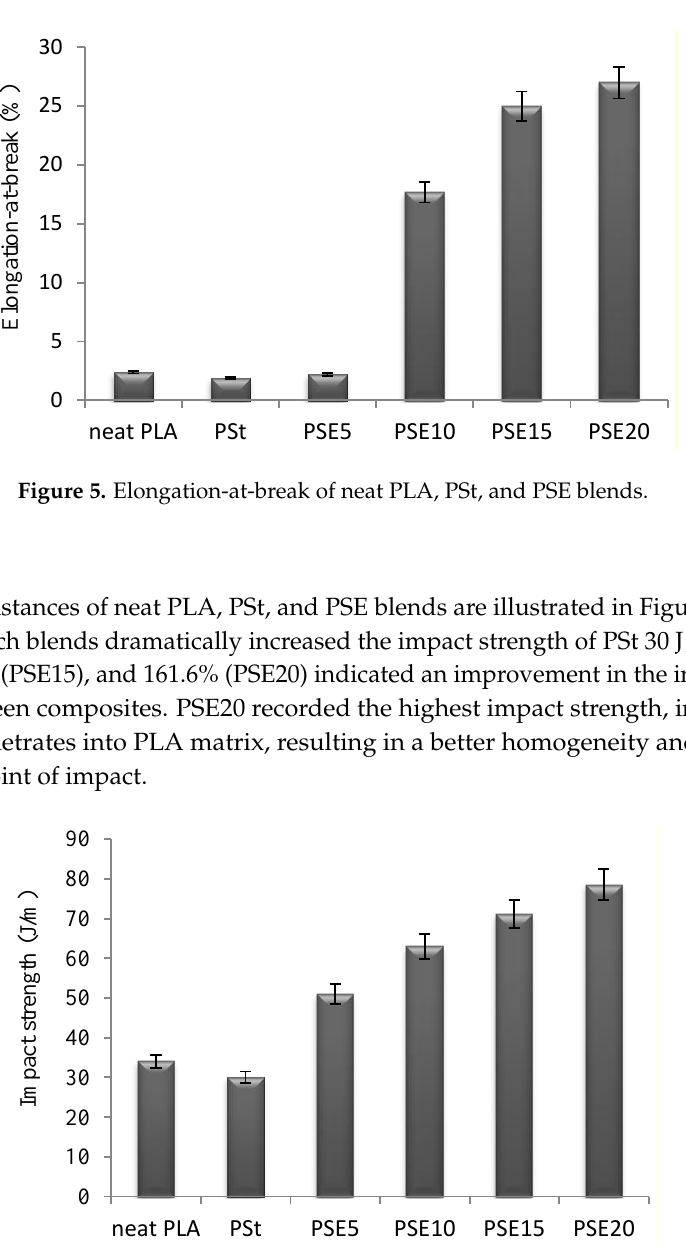
Figure 6. Impact strength of neat PLA, PSt, and PSE blends.